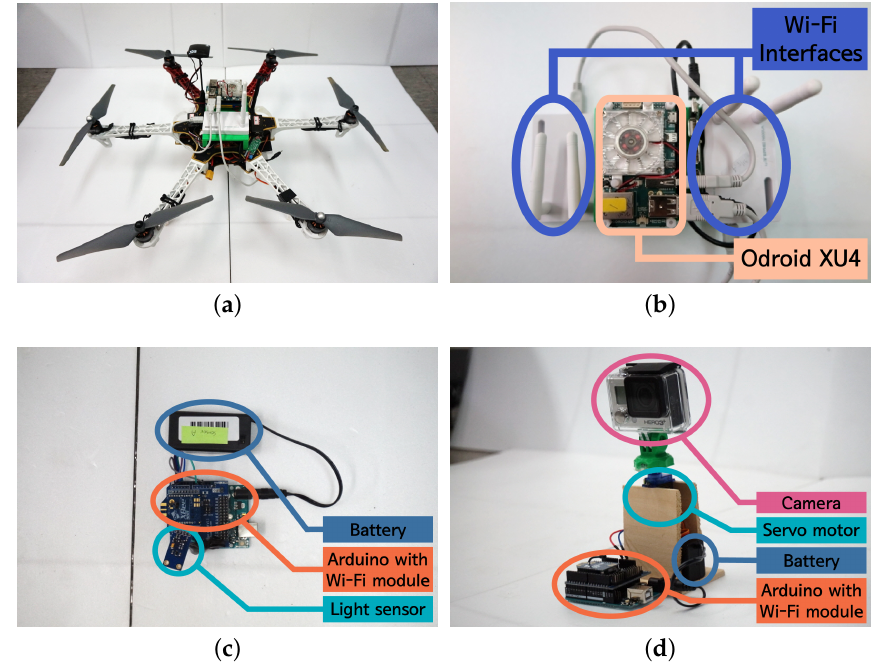
Figure 11. The implementation of DaaG, sensors and actuators. ( a ) The hexa-copter-based DaaG. ( b ) The computing module. ( c ) The IoT sensor module. ( d ) The IoT actuator